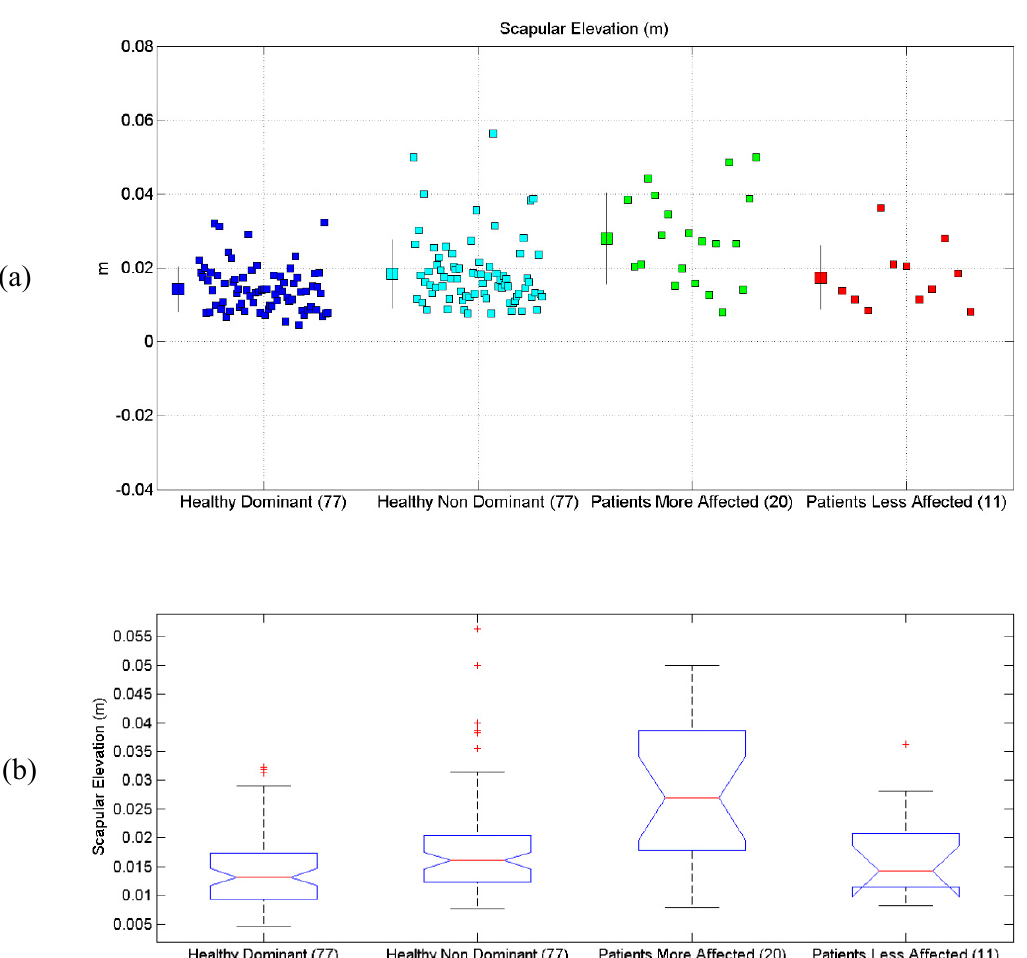
Figure 7. ( a ) Scatterplot for Scapular Elevation for the four considered groups. Mean (SD) of each population (considered limb) are reported. ( b ) Distributions of Scapular Elevation, are shown for the four experimental conditions. The central line indicates the median, while the lower and upper extremities of the boxes represent the 25th and 75th percentiles, respectively. The whiskers comprise all the data points distribution except the outliers, which are plotted separately using the ‘+’ mark.